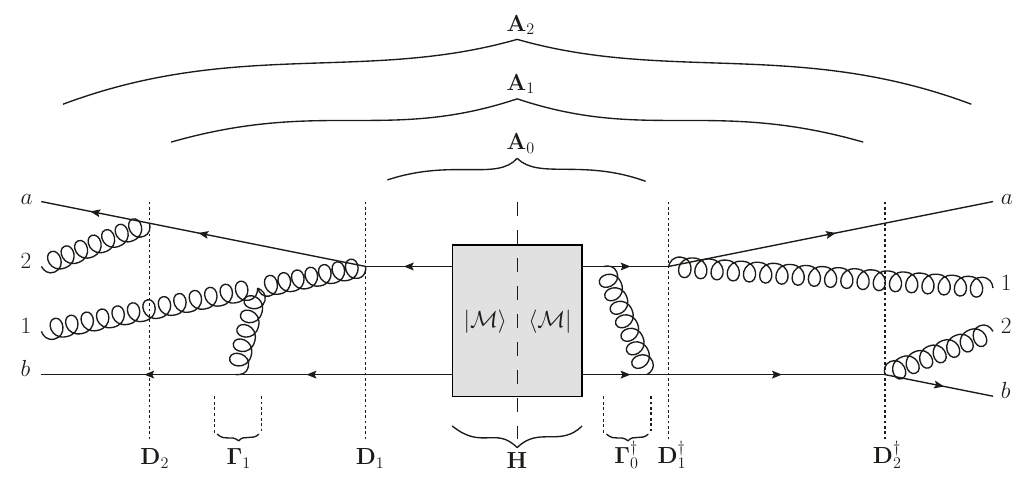
Figure 1 . A general term in the Markov chain of amplitude density matrices, A n , constructed by the PB algorithm. H is the initial hard process; in this case it has two hard coloured (cid:17) jMi hMj legs, a and b . D n dresses an amplitude with the n th emission that is either soft or collinear. Collinear emissions are emitted symmetrically from the amplitude and conjugate amplitude, such as gluon 1. Soft emissions appear as interference terms, such as gluon 2. (cid:0) n dresses the amplitude after n soft or collinear emissions with a